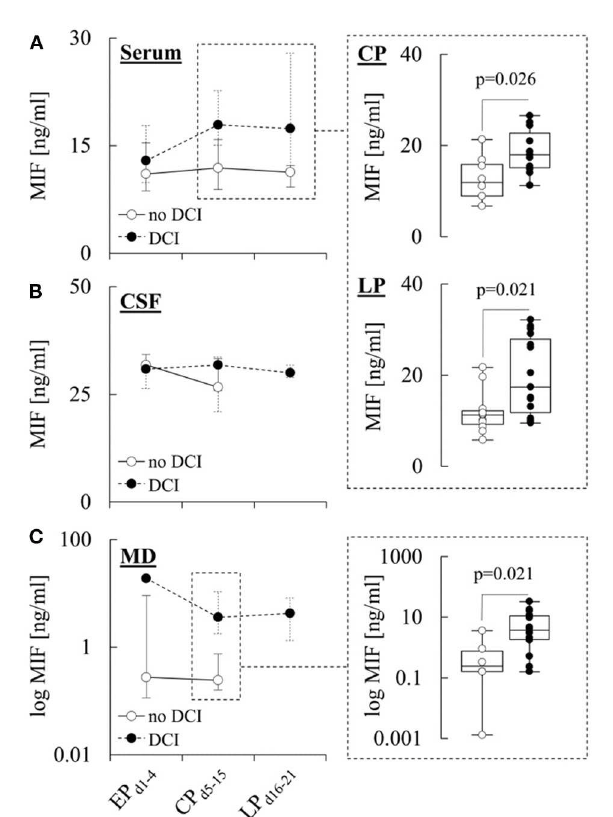
FIGURE3 MIF levels in different compartments and the development of DCI. Concentration of macrophage migration inhibitory factor (MIF) in (A) serum, (B) cerebrospinal fluid (CSF), and (C) microdialysate (MD) from patients with or without delayed cerebral ischemia (DCI) during the early (EP d1 − 4 ), critical (CP d5 − 15 ) and late (LP d16 − 21 ) phase after aneurysmal subarachnoid hemorrhage (aSAH). Data are shown as median [25th − 75th percentile] and (for significant differences) as boxplots and individual values (see insets). Statistical significance was assessed using the Mann-Whitney U -test. For details on the exact number of patients per time-point see Supplementary Tables